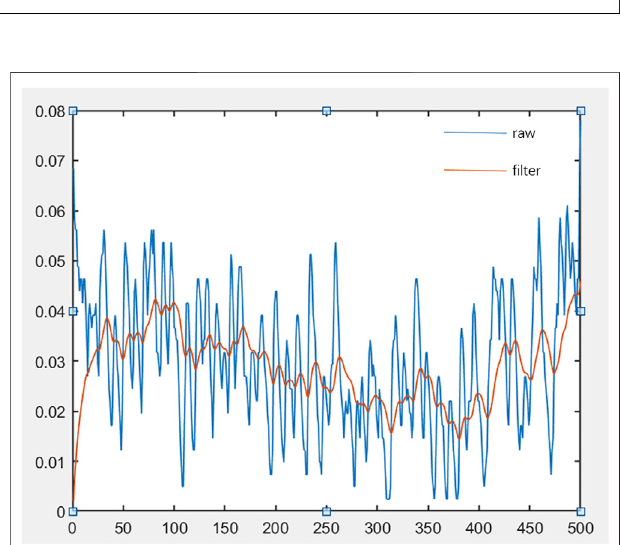
FIGURE 7 | Signal acquisition fl owchart.